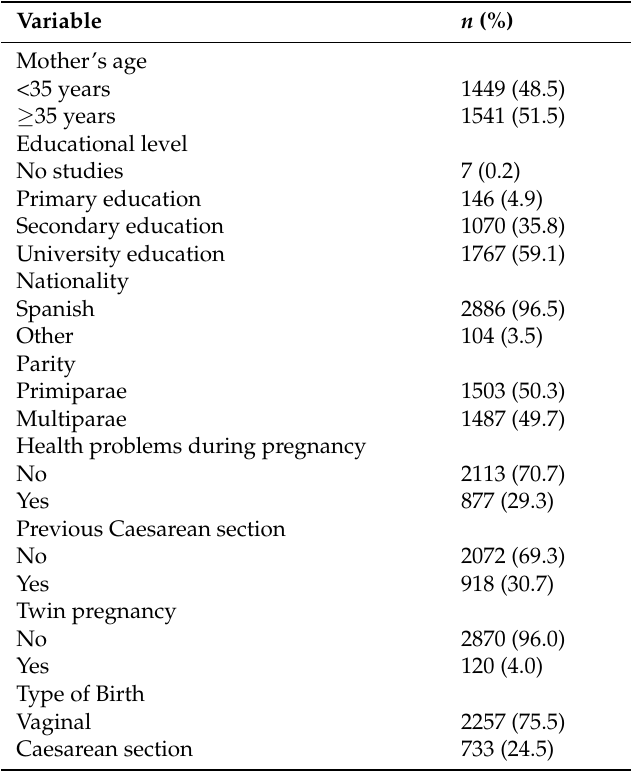
Table 1. Characteristics of the study